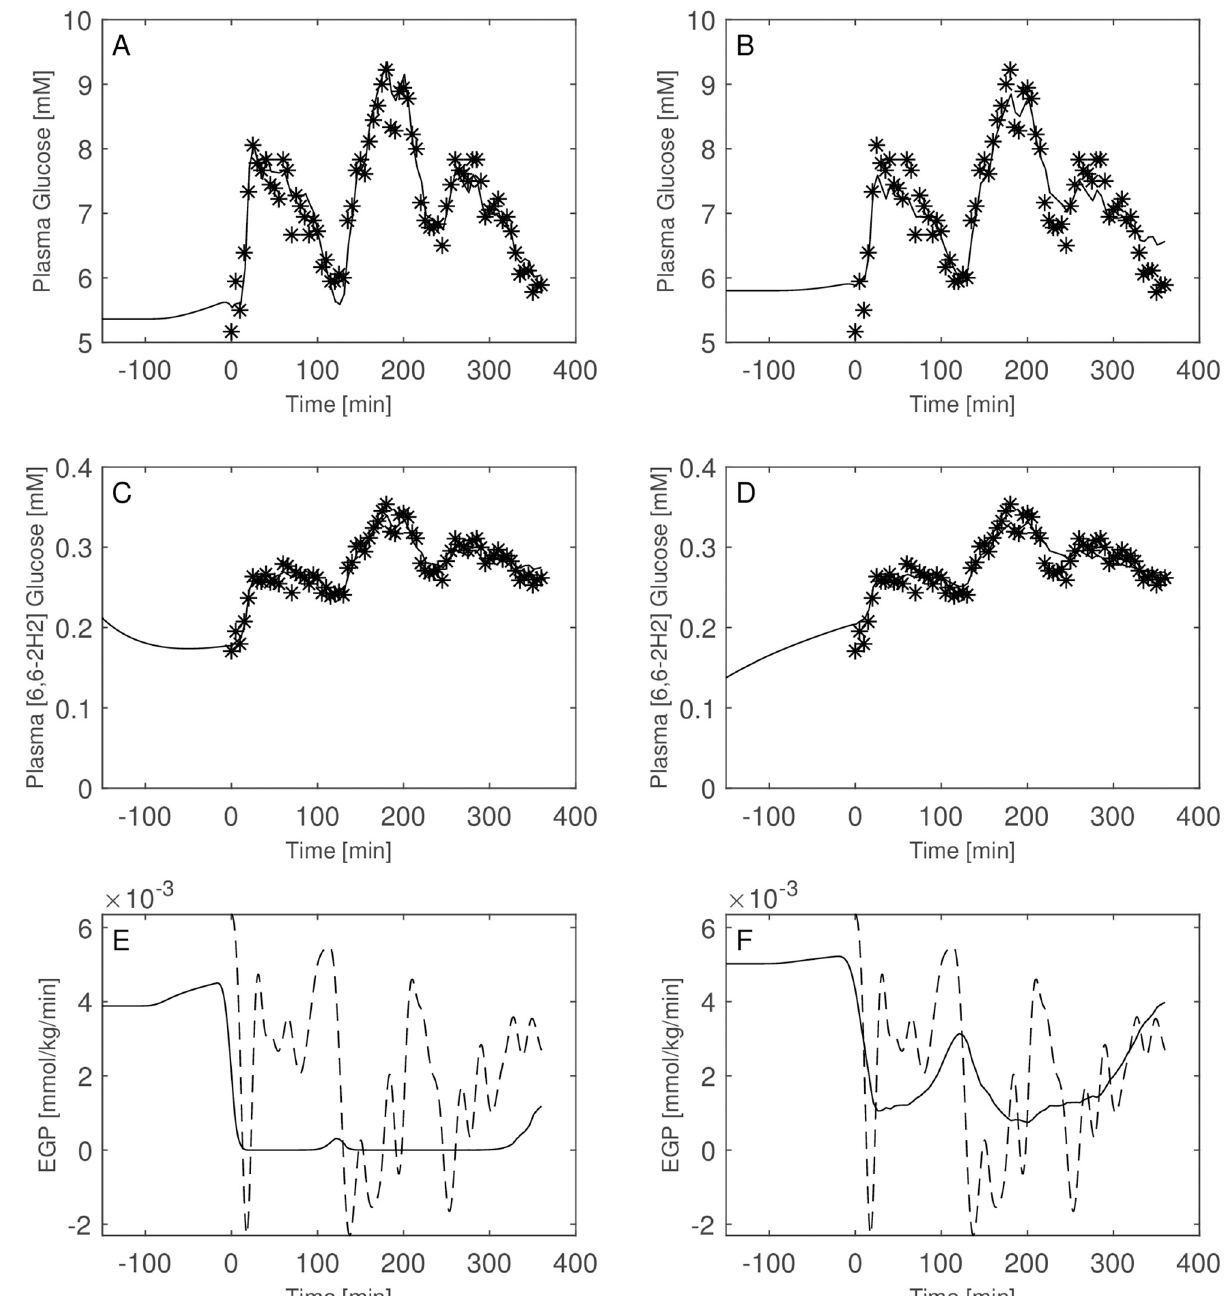
Fig 14. Model comparison for Subject 6. Observed (asterisks) and predicted (line) variables over time with glucose two-compartment model (Panels A, C, E) and one-compartments-glucose model (Panels B, D, F). Dashed line is the predicted EGP with the Steele model. All the observed points refer to data measured on day 2. Plasma glucose concentrations (panel A) are derived from the glucose intra-venous infusion to match plasma glucose observations from the OGTTs of day 1.